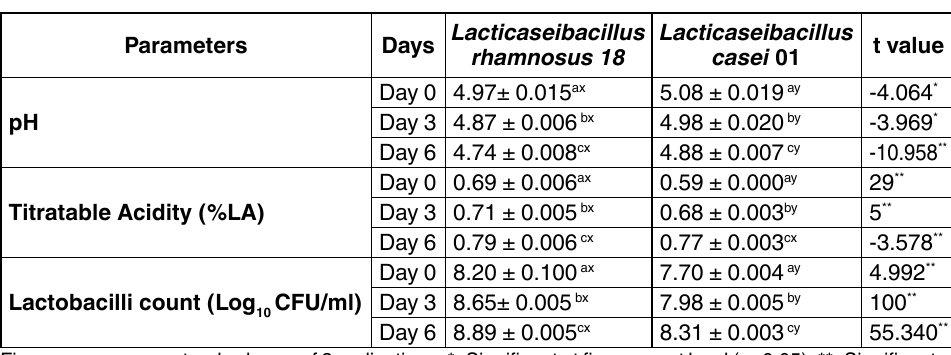
Table 1. pH, titratable acidity and count of Lacticaseibacillus rhamnosus 18 and Lacticaseibacillus